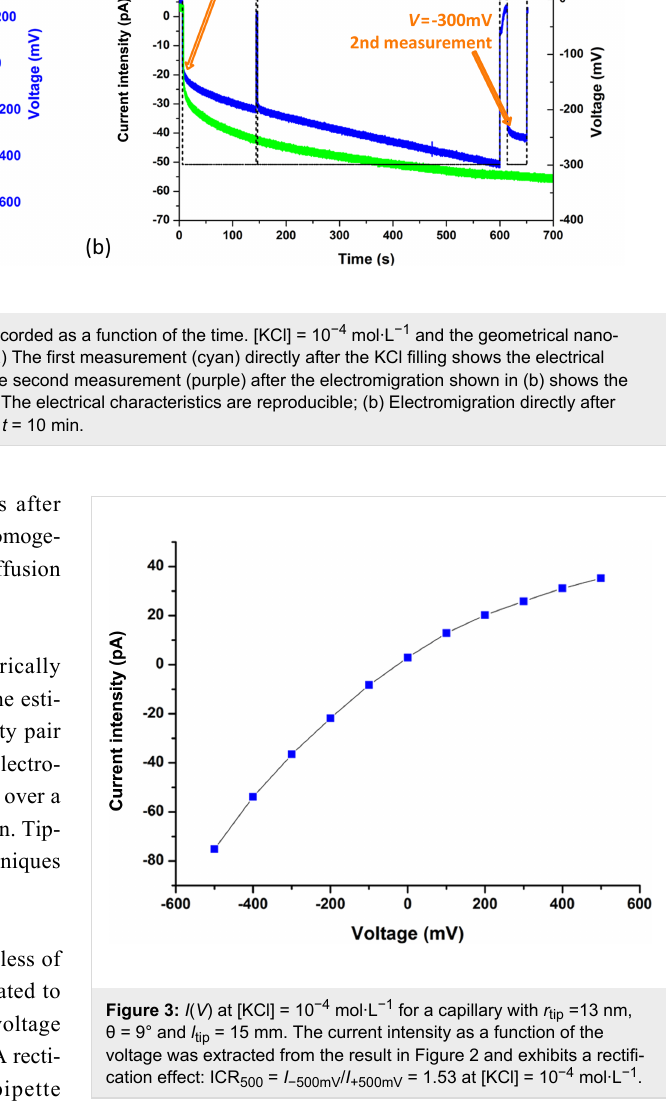
Table 1: Current intensity measurements made at V = − 500 mV and at the salt given concentration before and after electromigration for t = 10 min for different tip-hole sizes.